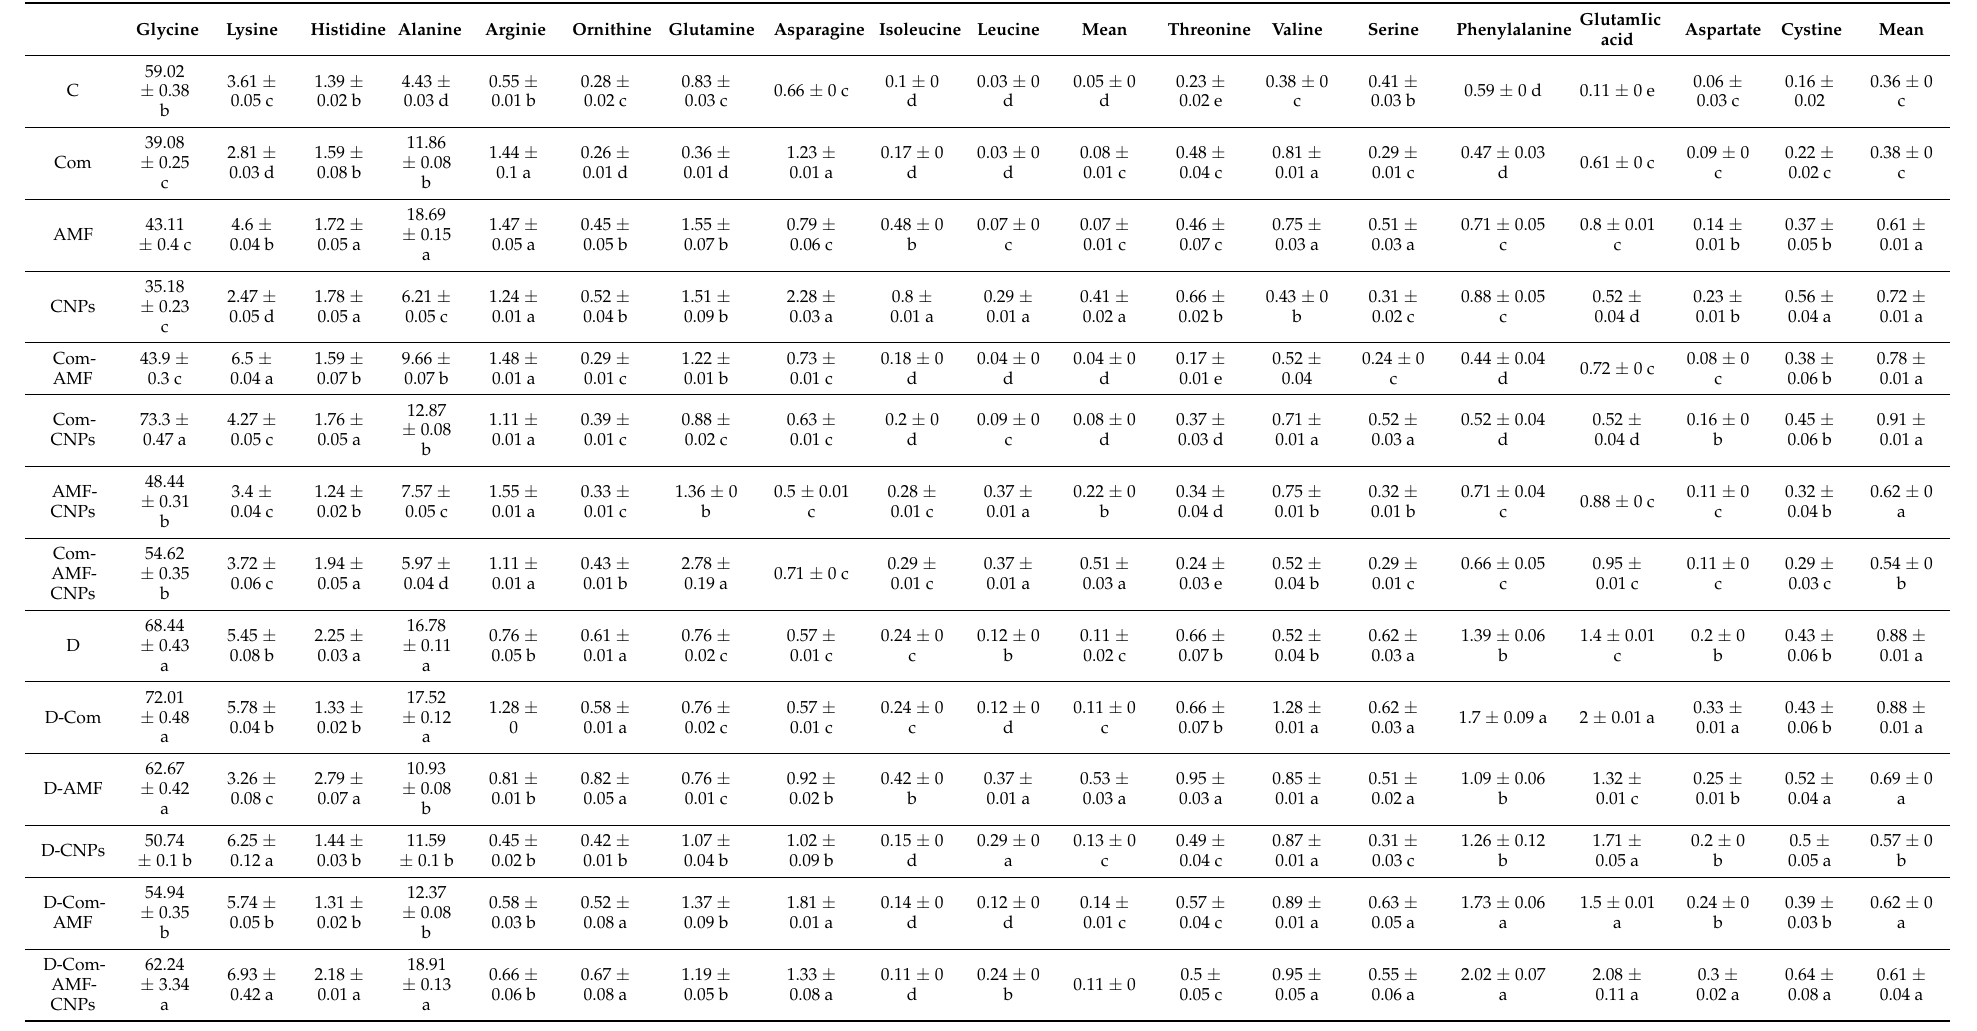
Table 3. Effect of different treatments on amino acids (mg g − 1 DW) of maize under control and drought (D) conditions. Different letters indicate statistically significant difference between means for the different treatments at significance level of at least p ≤